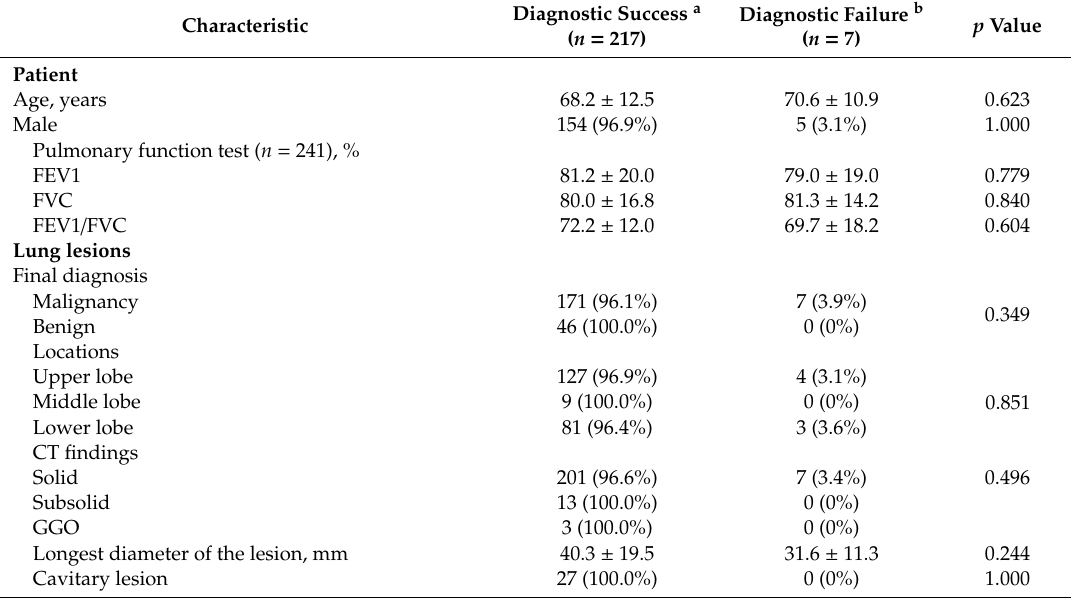
Table 5. Results of univariate analyses of the risk factors associated with diagnostic